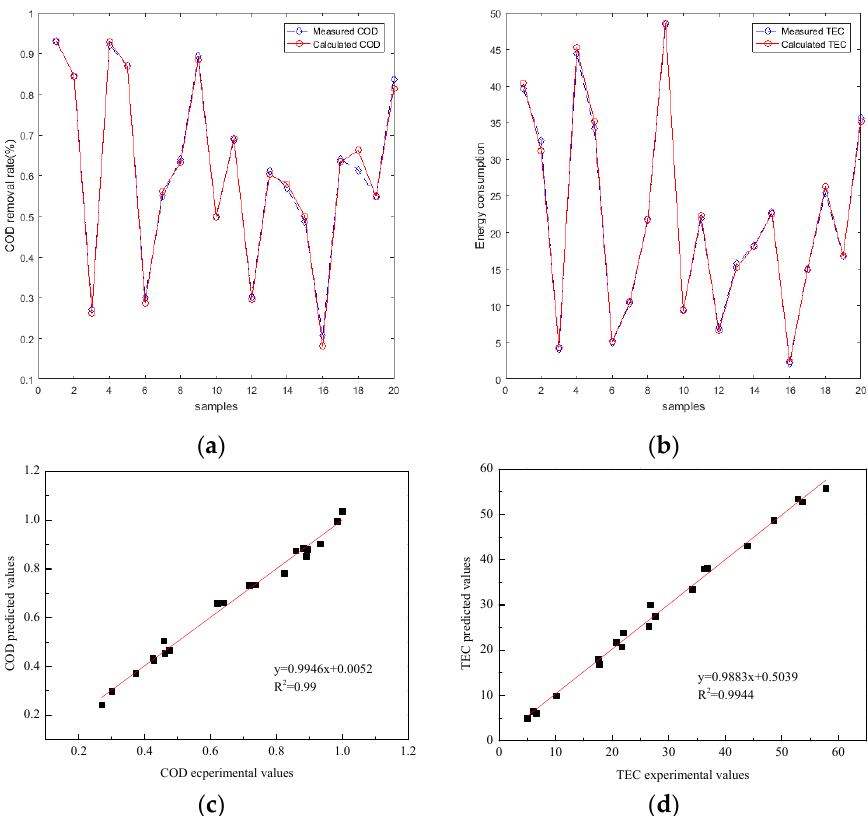
Figure 6. Performance of the particle swarm optimization BP-ANN (PSO-BP-ANN) predicting COD removal efficiency and TEC between experimental and predicted data sets (COD removal efficiency testing set ( a ), TEC testing set ( b )); correlations between experimental and predicted set (COD removal efficiency testing set ( c ), TEC testing set ( d )).